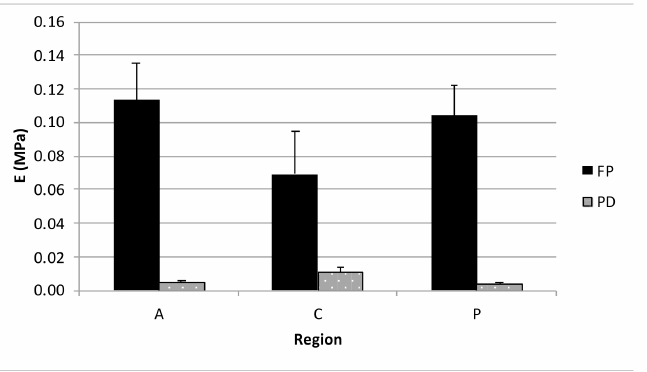
Figure 8. Comparison between compressive moduli for FD and PD menisci at the 0.12 strain level for three regions: anterior (A), central (C), and posterior (P). Bars are standard